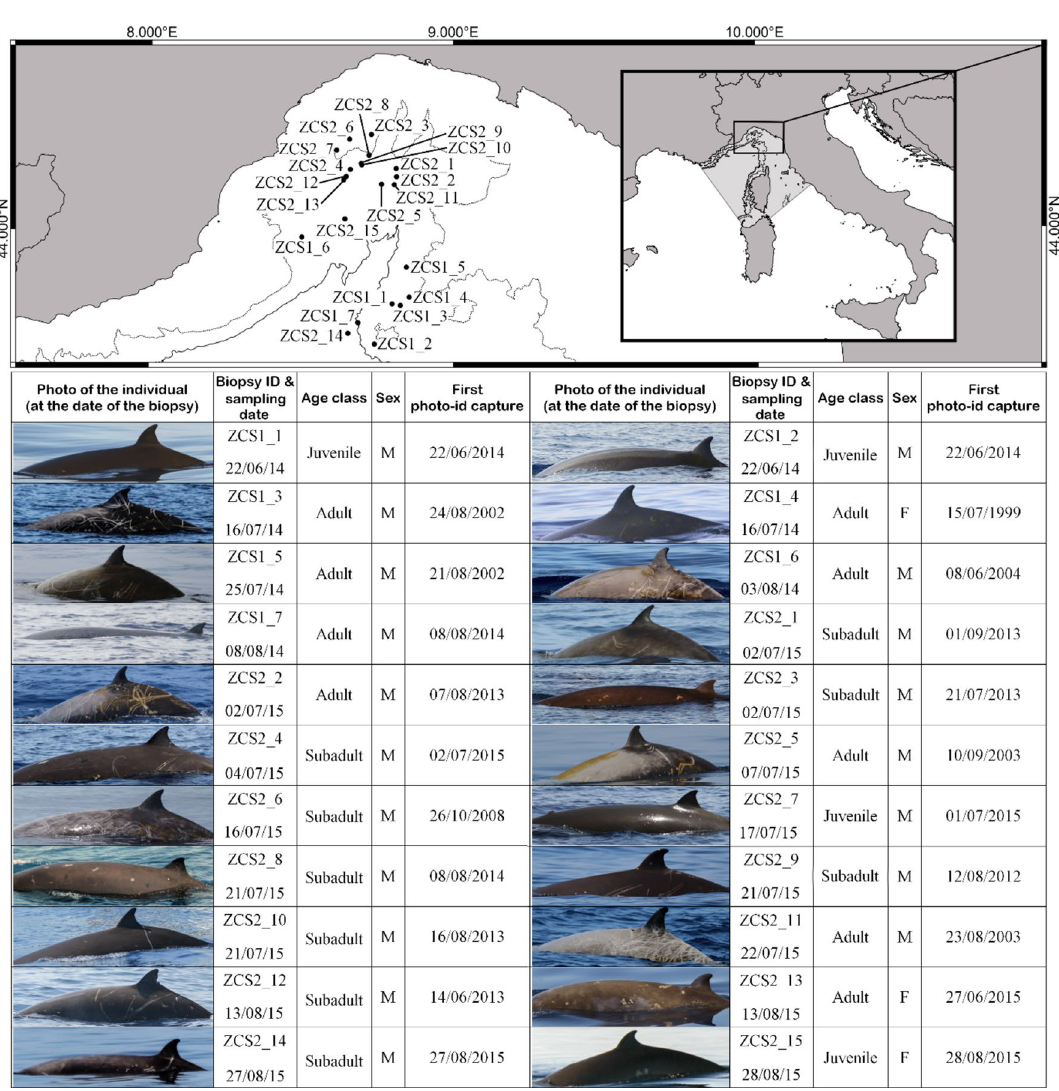
ZCS2_13 = 0.231 mg/kg l.w.) than those shown in adult males. The PBDEs congener profile shown in Fig. 3, was